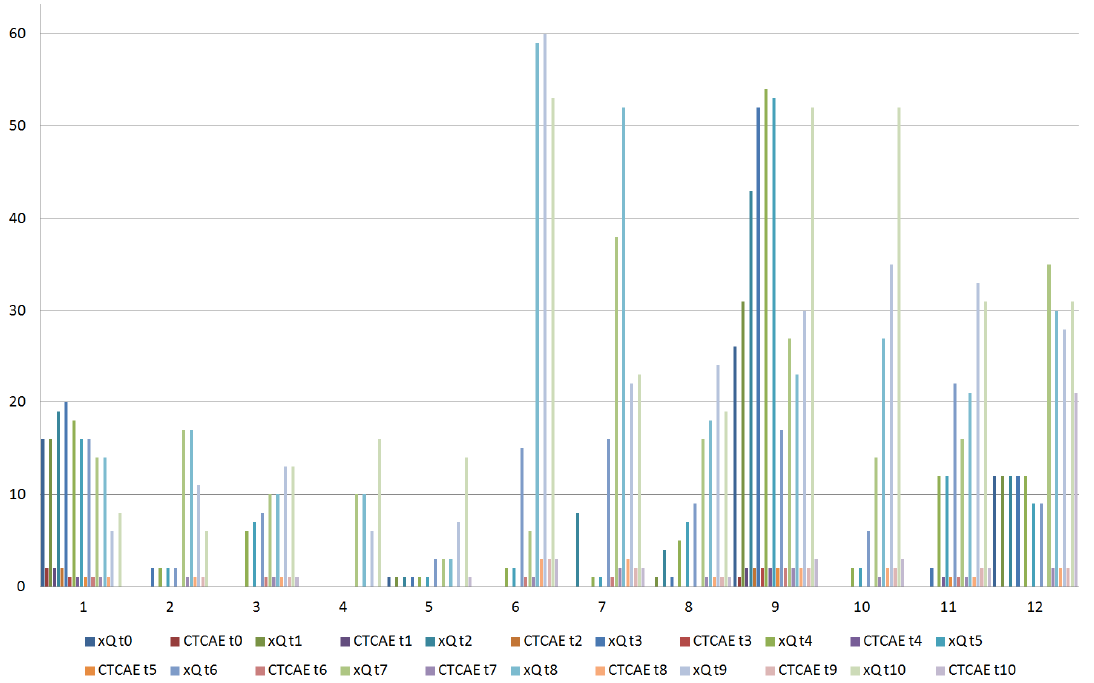
Figure 1. Patient-reported (xQ) and clinician-reported (CTCAE) acute xerostomia results. Time points: at baseline (t0); during the first week of treatment, before each fraction of CRT (t1, day one; t2, day two; t3, day three; t4, day four; t5, day five); and then at intervals of one week after the start of CRT (t6, week two; t7, week three; t8, week four; t9, week five; t10, week six). Serum salivary amylase values as a function of time are depicted in Figure 2. The main effect of the time showed significant difference for amylase with a significant de- crease in the levels of salivary amylase from day three (t3) of radiotherapy to day four (t4) of RT ( p = 0.003).